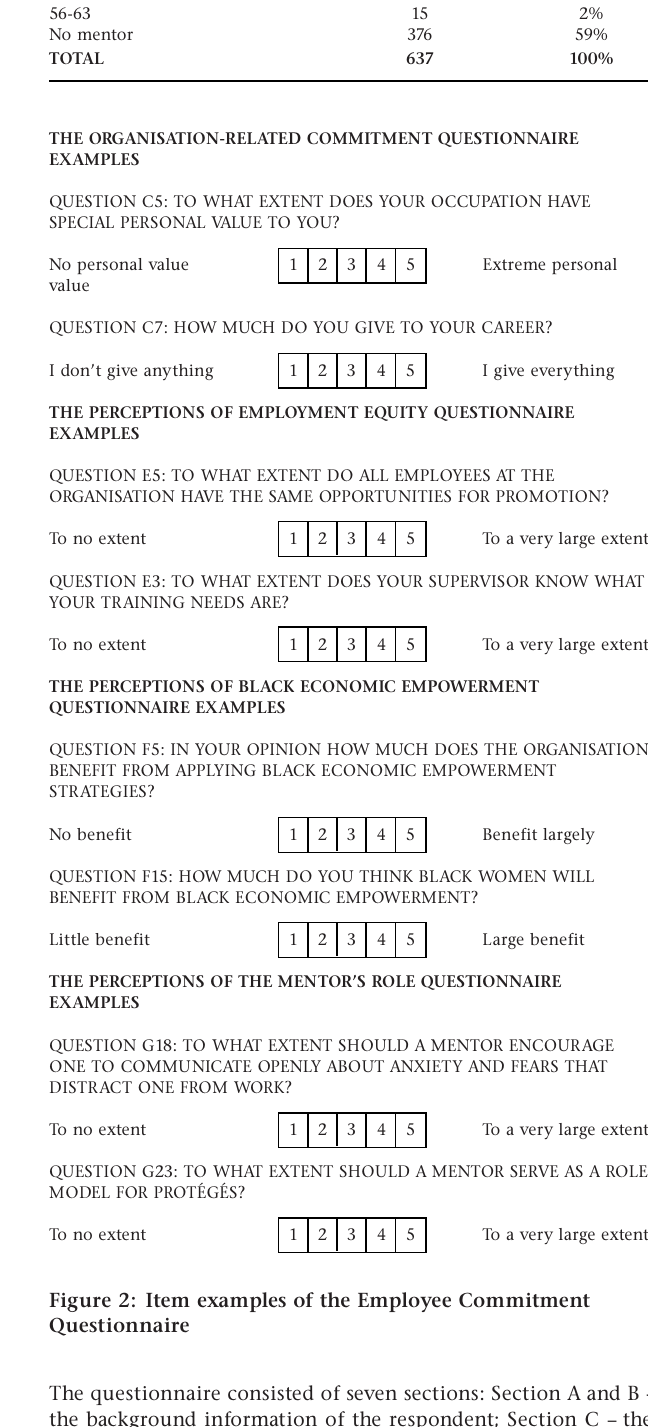
Figure 2: Item examples of the Employee Commitment